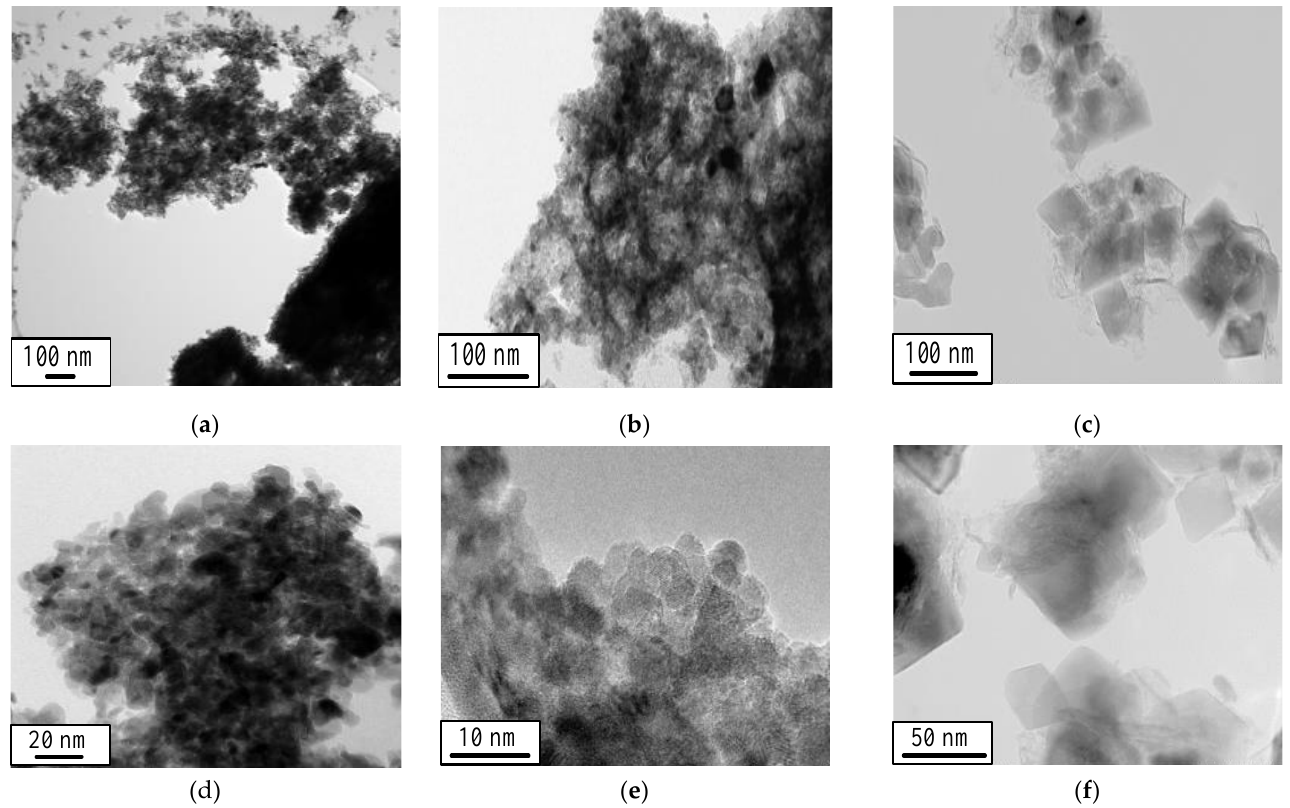
Figure 6. Typical TEM images of catalysts synthesized using solution combustion and various fuels: ( a , d ) HMTA; ( b , e ) glycine; ( c , f ) oxalic acid.